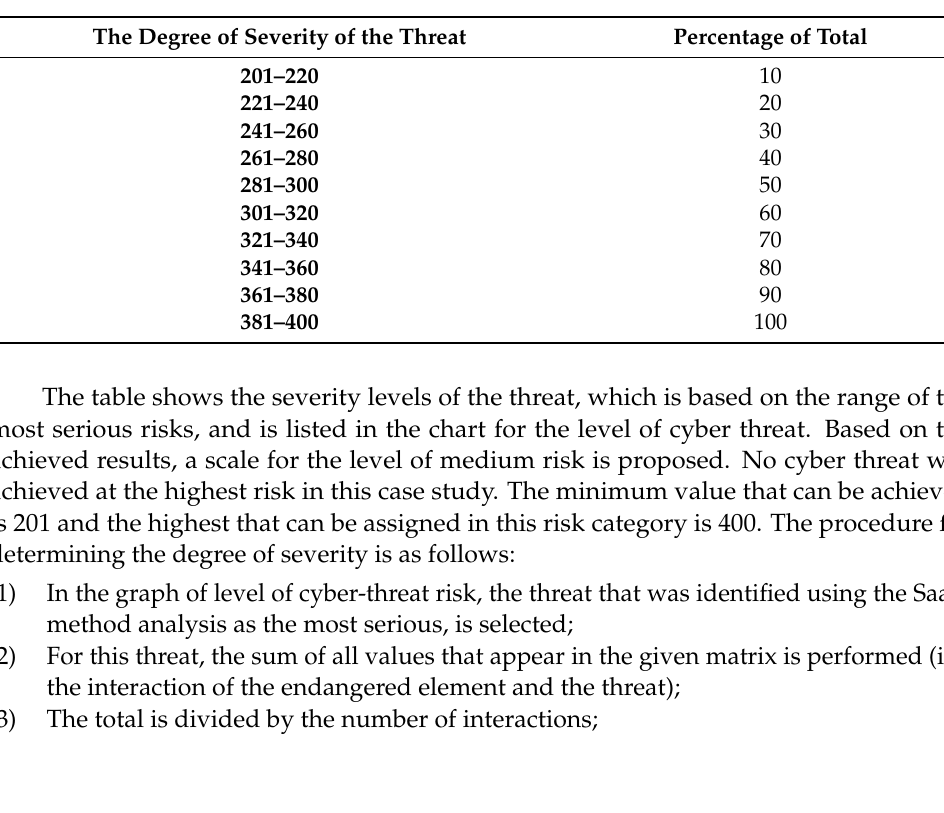
Table 9. Threat-severity classification (own